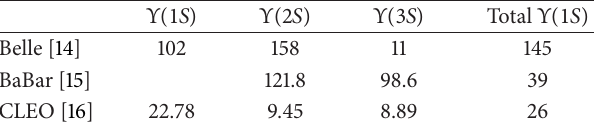
Table 1: Summary of data samples (in the unit of 10 6 ) of the Υ(𝑛𝑆) particles below 𝐵𝐵 threshold collected by Belle, BaBar, and CLEO collaborations. The data in the 5th column correspond to total number of the Υ( 1 𝑆) particles, including events from hadronic dipion transitions between upsilons Υ( 2 𝑆, 3 𝑆) → 𝜋𝜋Υ( 1 𝑆) , where branching ratios for the dipion decays Υ( 2 𝑆) → 𝜋 + 𝜋 − Υ( 1 𝑆) , 𝜋 0 𝜋 0